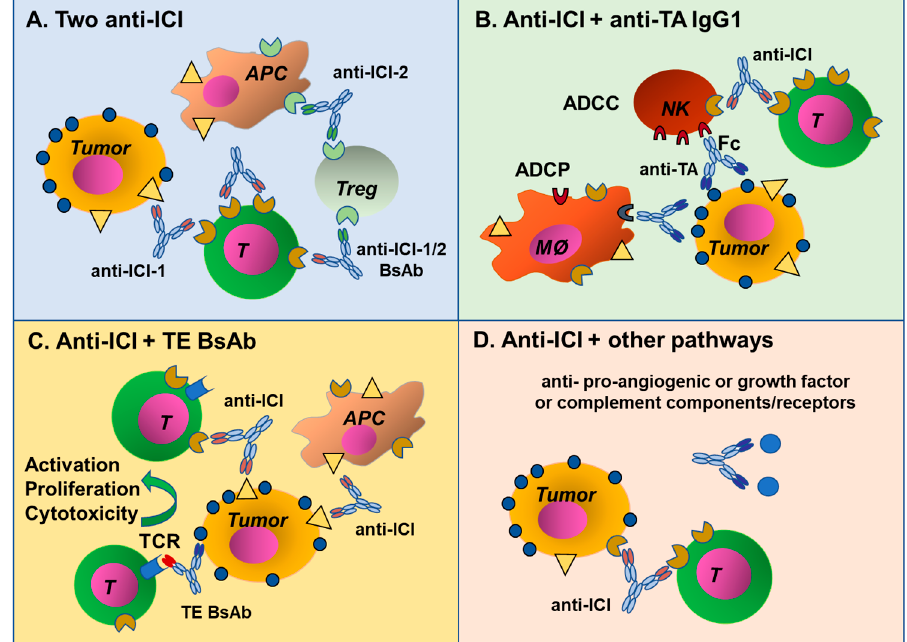
Figure 3. Mechanisms of antibody combinations. ( A ) Antibody combinations targeting two ICI, either as single MAbs or BsAbs. ( B ) Two MAbs targeting an ICI and a tumor antigen, these can also be combined in a BsAb format. ( C ) Combination of a MAb targeting an ICI with a TE BsAb and ( D ) an ICI antibody can be combined with MAbs blocking different pathways involved in tumor growth and metastasis, such as antibodies blocking angiogenic or growth factors, or complement factors and their receptors.